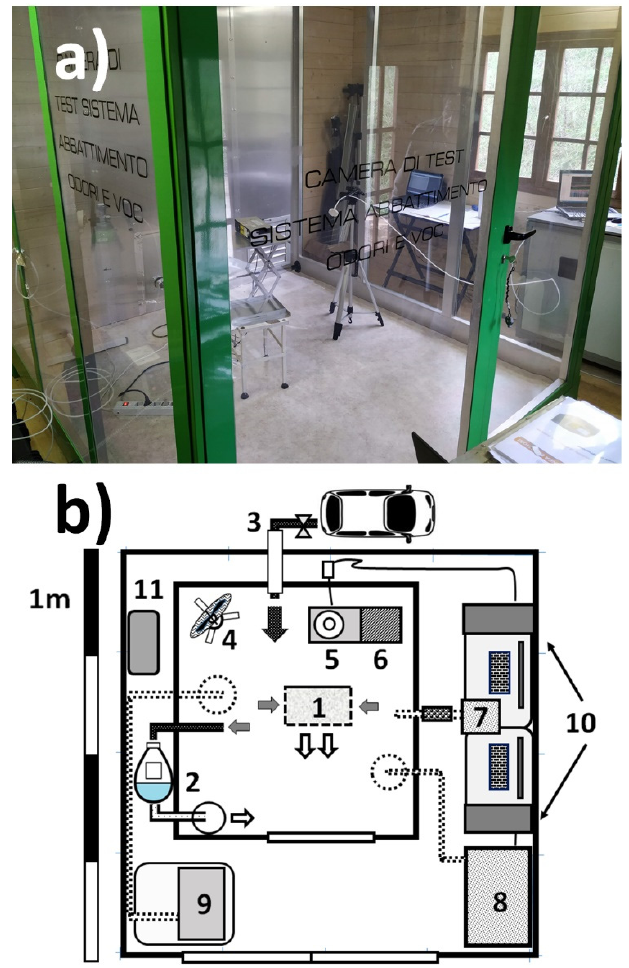
Figure 1. ( a ) Picture of the testing room. ( b ) Map showing the position of the instruments, air cleaners and emission sources: (1) air cleaner operating indoors; (2) air cleaner operated from outdoors; (3) line to introduce car exhaust emissions and resuspended soil particles; (4) fan; (5) optical particle counters; (6) monitors for PM 2.5 , PM 10 , total VOCs, formaldehyde and NO 2 ; (7) samplers to collect VOCs on sorbent tubes; (8) PTR-MS; (9) monitor of O 3 , NOx, CO and CO 2 ; (10) data acquisition systems; and (11) air conditioning system. Dotted lines = sampling lines. Dotted lines with circles = sampling lines passing from the top of the ceiling.